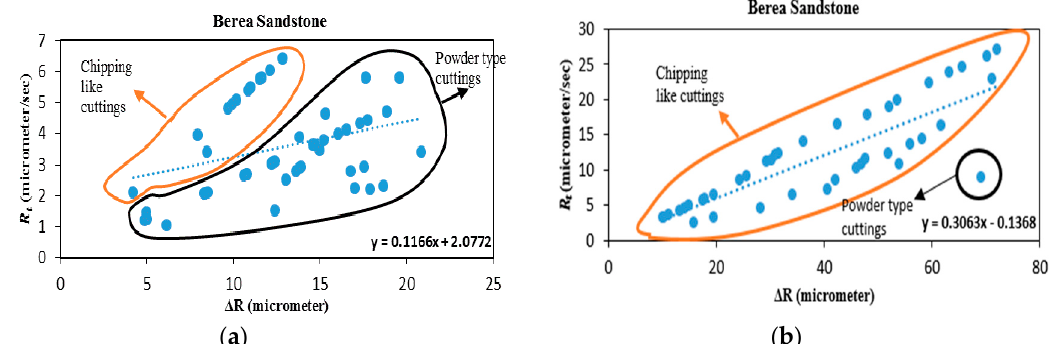
Figure 15. Evolution of chunk like cuttings and powder cuttings at different DOCs: ( a ) d = 0.2 mm; ( b ) d = 1.4 mm.